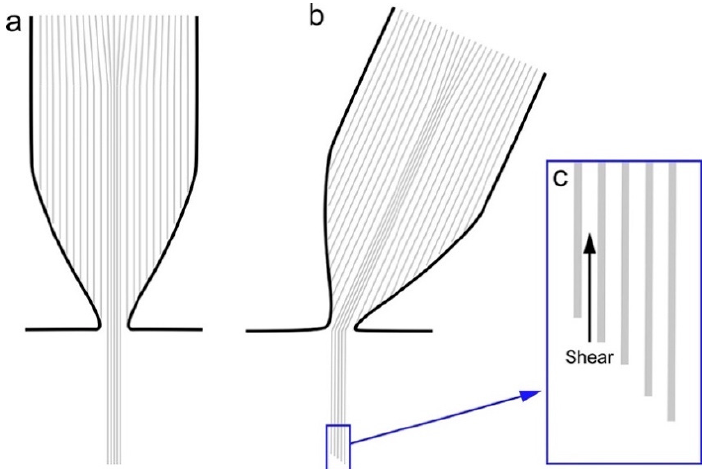
Figure 3. Hypothesis for rootlet filament movement during stereocilia pivoting. ( a ) Rootlet actin filaments are mechanically similar to 1/4” steel cables—flexible but inextensible. Multiple rootlet filaments are bundled together, probably with TRIOBP. ( b ) If rootlet filaments are capable of shearing (sliding with respect to each other), then during stereocilia pivoting, filaments furthest from the direction of the pivoting (left in this diagram) will shear more than those closest to the direction of pivoting. ( c ) Magnified view of the soma ends of rootlets illustrating differential shear of rootlet filaments.